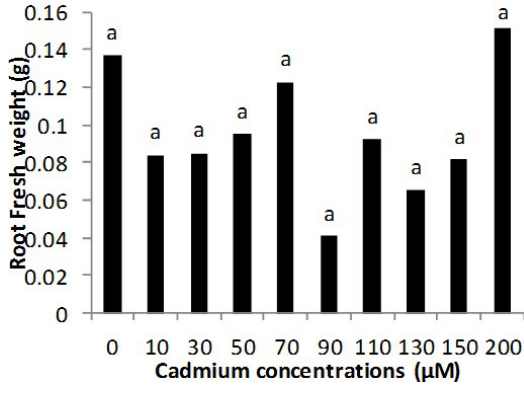
Fig. 4 . Effects of cadmium on root fresh weight of Brassica napus L.